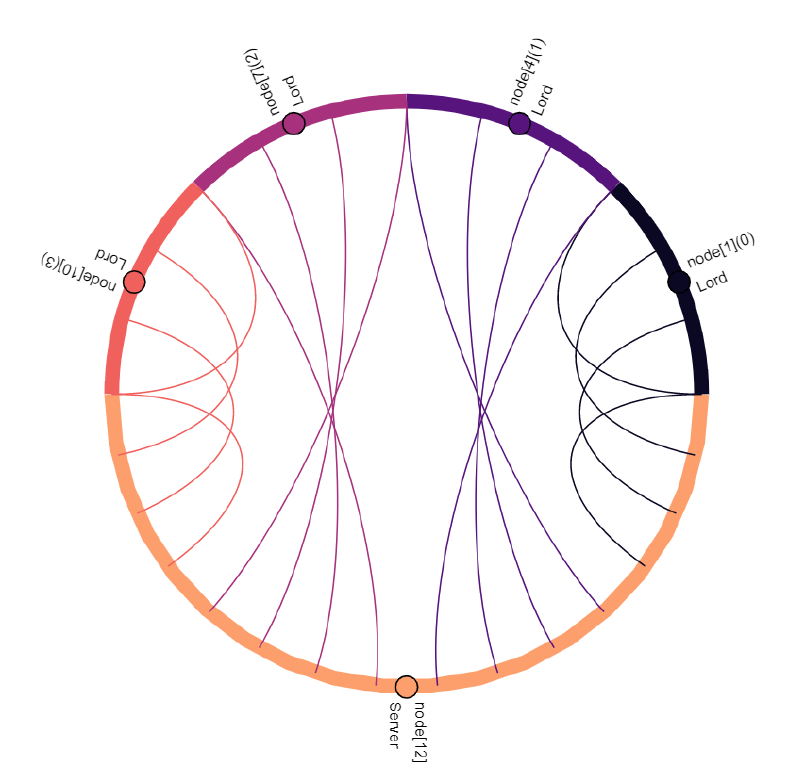
Figure 11. The vassalage lords request data from another vassalage of their platoon at the central server.